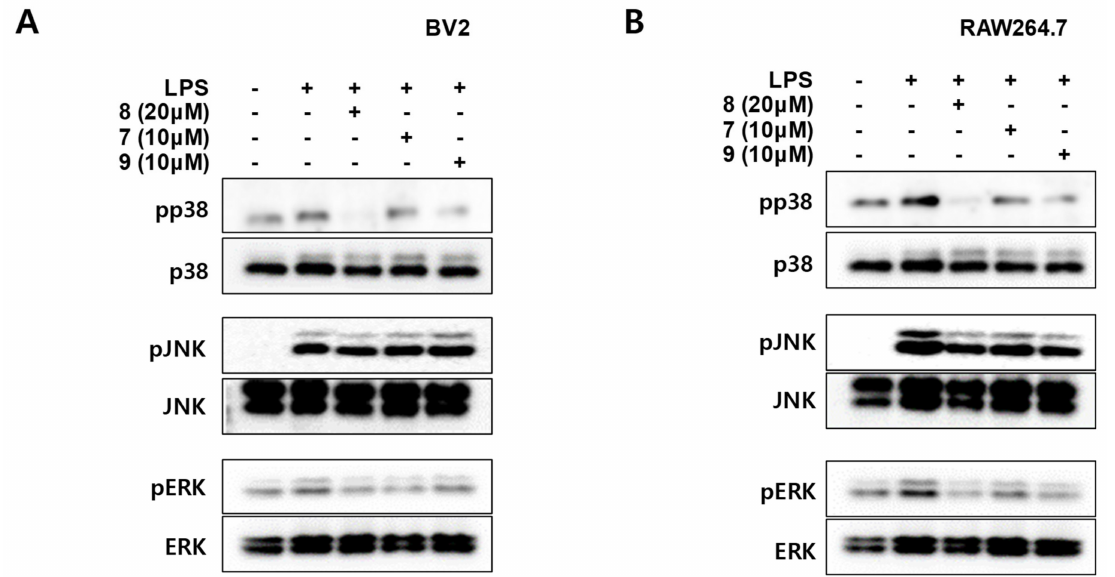
Figure 7. Effects of compounds 7 – 9 on p38, JNK-1/2, and ERK-1/2 phosphorylation in BV2 ( A ) and RAW264.7 ( B ) cells. Cells were pretreated with indicated concentrations of compounds 7 – 9 for 3 h and stimulated for 30 min with LPS (1 µ g/mL). Cell extracts were analyzed using Western blotting with antibodies specific for phosphorylated p-p38, p-JNK1/2, and p-ERK1/2. Membranes were stripped and re-probed to measure total abundance of each mitogen-activated protein kinase (MAPK) as a control measurement. Representative blots from three independent experiments are